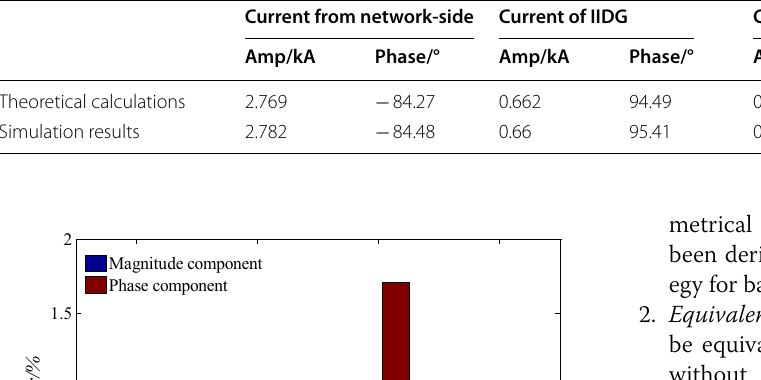
Table 4 Fault current calculations/simulations under a three‑phase fault at point f